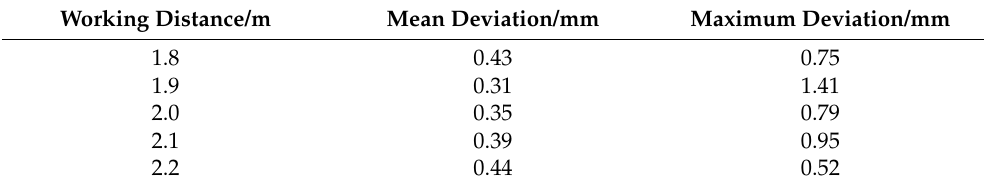
Table 2. Average deviation and maximum deviation at different working distances.